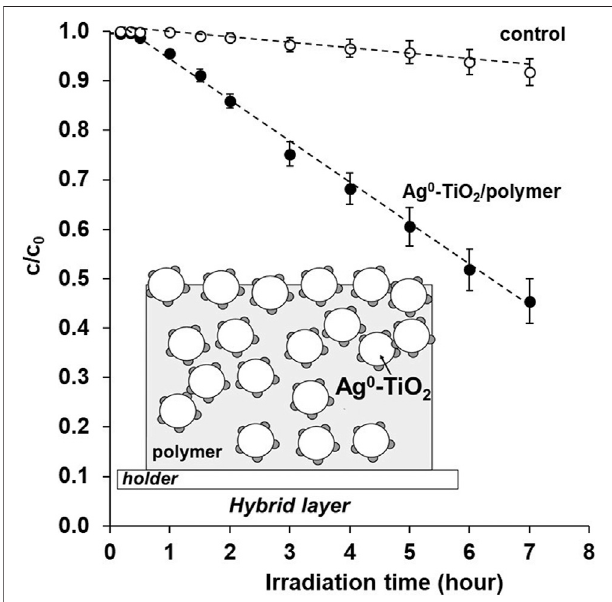
FIGURE 4 | Photocatalytic degradation rate of benzoic acid test molecules on Ag 0 -TiO 2 -containing polymer-based nanohybrid thin fi lms as a function of irradiation time under visible-light illumination. Inset: scheme representing the nanohybrid fi lm.